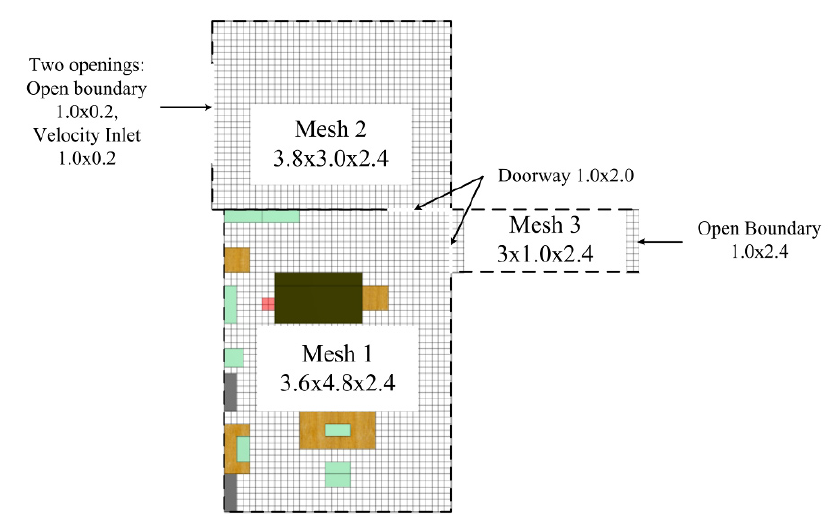
Figure 2. Meshes geometry for grid independent